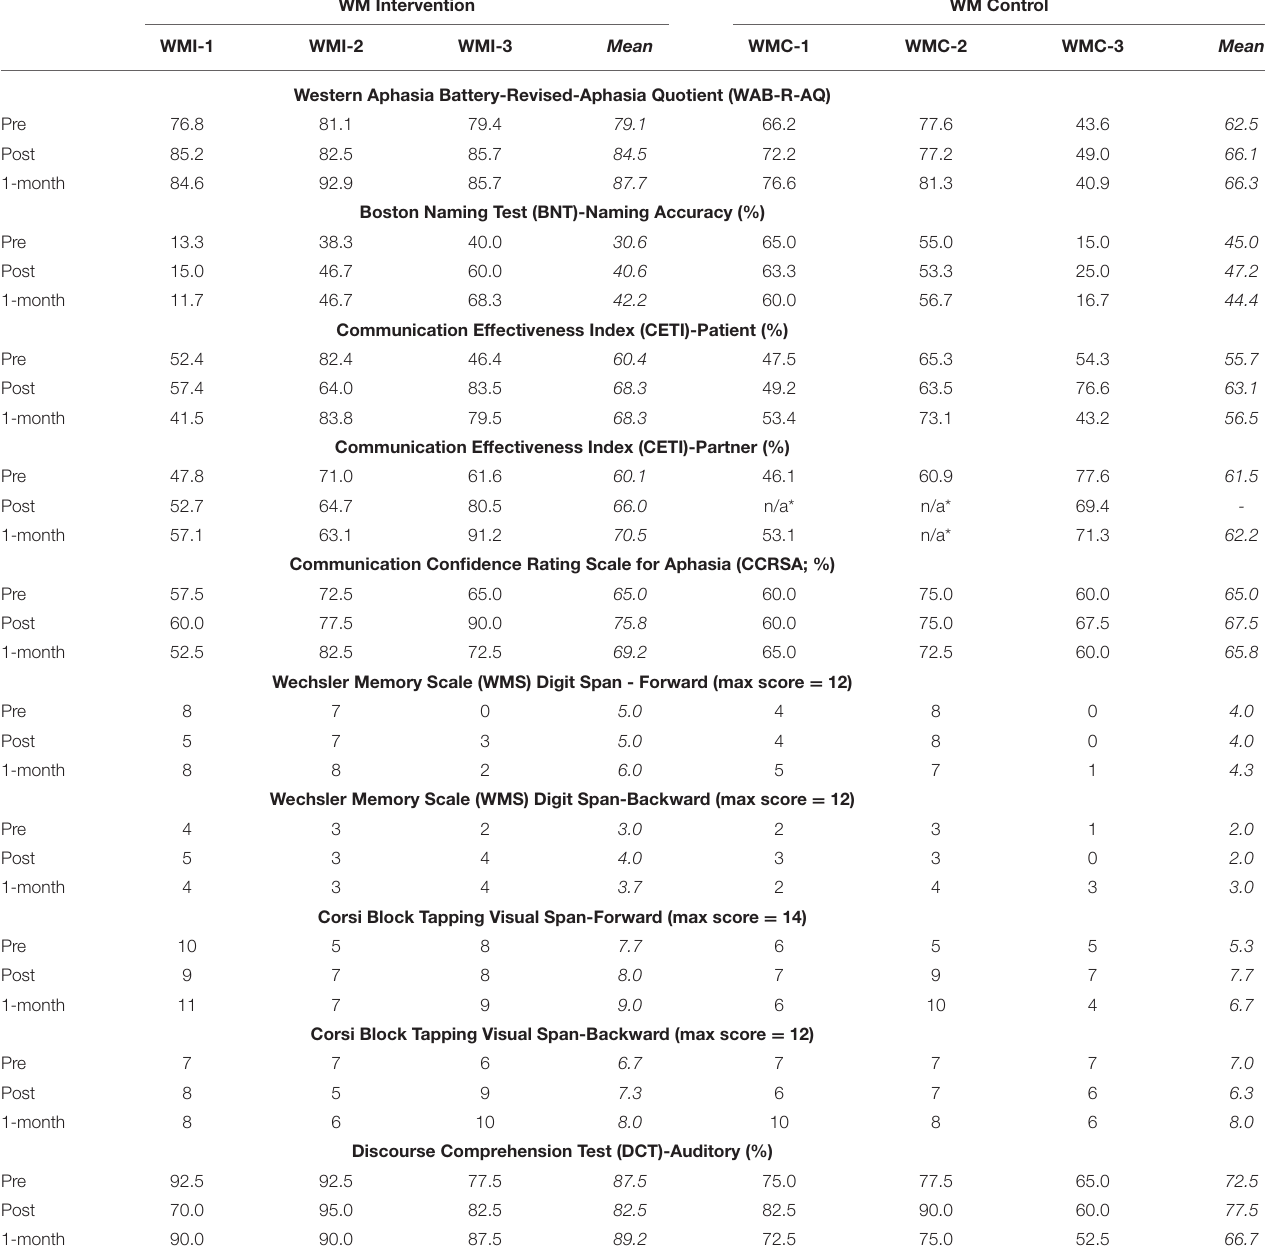
TABLE 3 | Individual participant scores on measures of anomia and aphasia severity, communicative effectiveness and confidence, WM and discourse comprehension across assessment times. WM Intervention WM Control WMI-1 WMI-2 WMI-3 Mean WMC-1 WMC-2